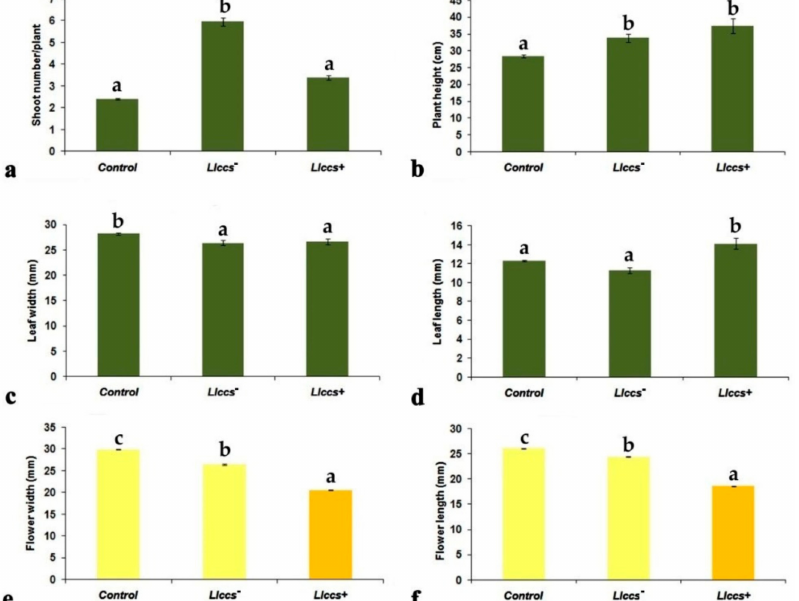
Figure 6. Morphological characteristics of control and transgenic ( Llccs − and Llccs + ) greenhouse- grown V. cornuta plants. ( a ) Number of newly developed shoot/plant; ( b ) Plant height; ( c ) Leaf width; ( d ) Leaf length; ( e ) Flower width; ( f ) Flower length. The data represent mean values ± standard error. Mean values within the same histogram marked with different letters differ significantly based on the Fisher’s LSD test ( p ≤ 0.01). Presented data include ten plants of three randomly selected lines—a total of 30 plants for each treatment.